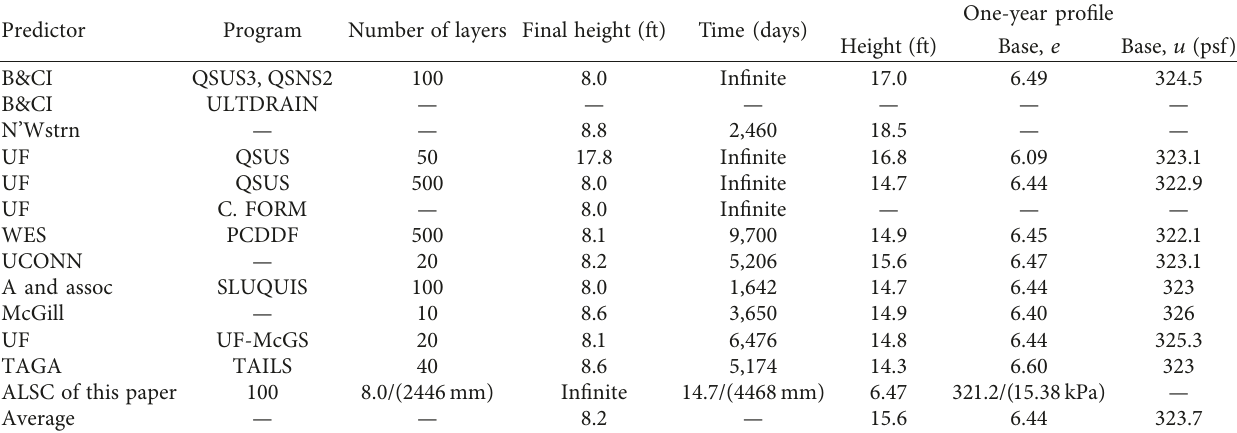
Table 2: Comparison of calculation results for consolidation of working condition C